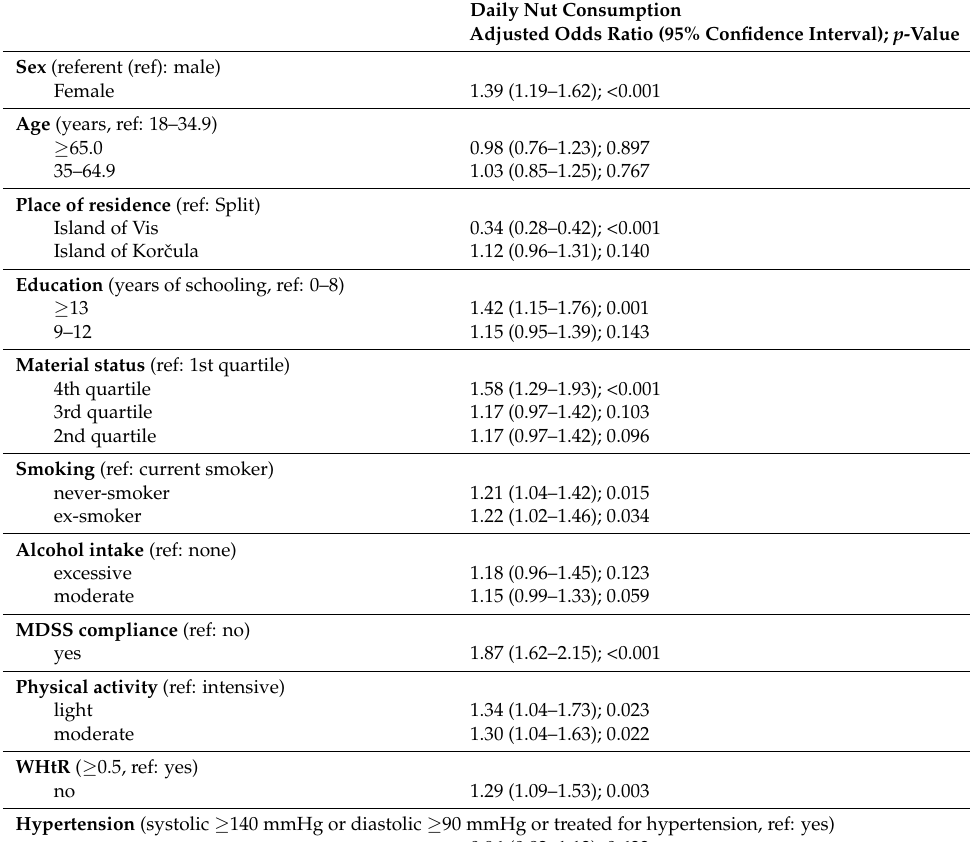
Table 2. Characteristics associated with nut consumption, as determined by the ordinal regression model (sample size is 4011 subjects without a previous diagnosis of cardiovascular diseases; all independent variables included in the model are listed in the